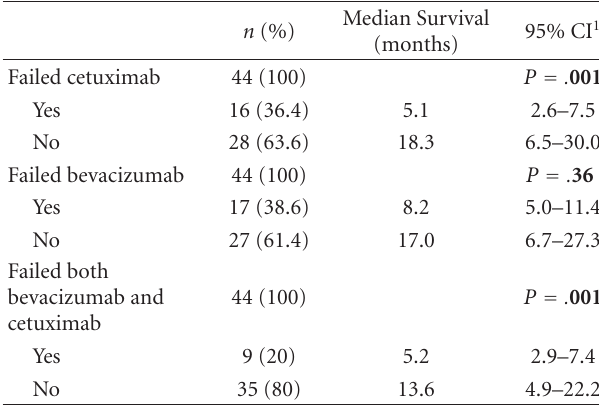
Figure 1: Kaplan-Meier survival curve comparing those with extrahepatic disease at the time of treatment versus those with disease localized to liver. The estimated median survival was 17.0 months for those without extrahepatic disease compared to 6.7months. This di ff erence was found not to be significant when using log-rank analysis, P - value of .07. Table 4: Survival analysis of those who had received bevacizumab and/or cetuximab prior to treatment with 90